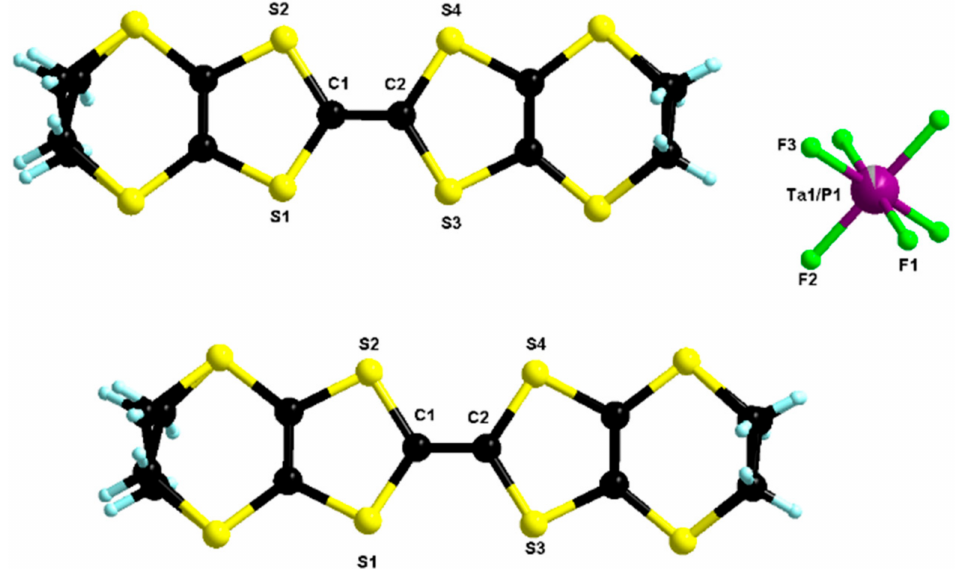
Figure 6. Molecular structure of δ m -(BEDT-TTF) 2 (TaF 6 ) 0.94 (PF 6 ) 0.06 . The two carbon atoms of the two ethylene parts were disordered over two positions with refined partial occupancy factors (0.77/0.23 and